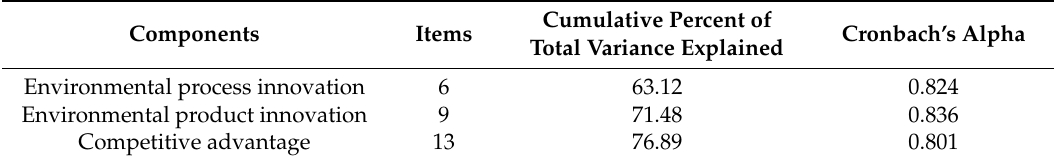
Table 5. Environmental innovation constructs.